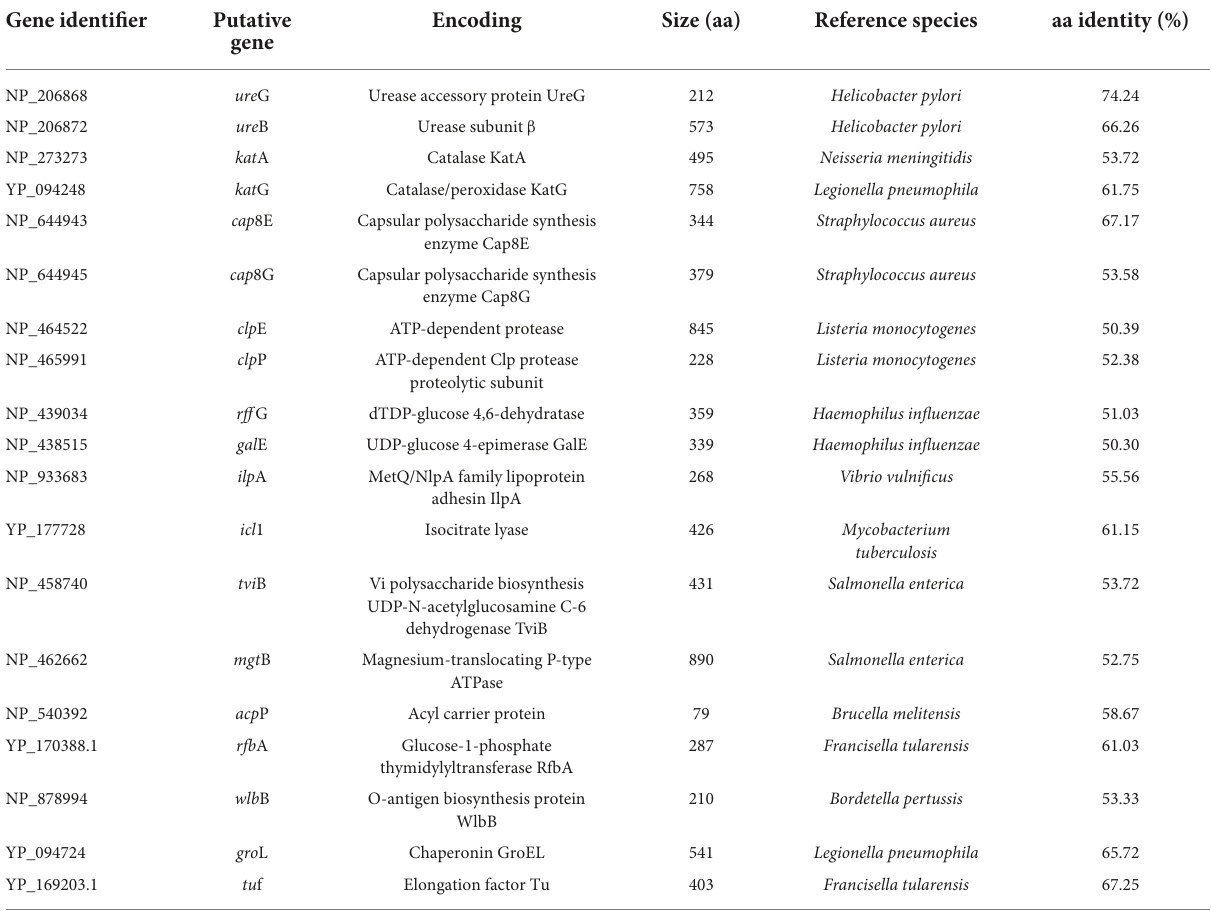
TABLE 2 Presence of virulence determinants in Chryseobacterium indologenes